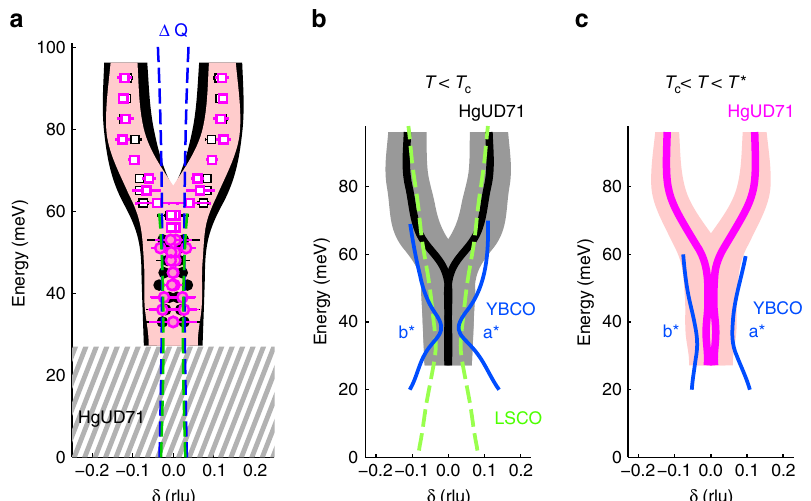
Figure 4 | Comparison of Y-shaped response of HgUD71 with magnetic excitation spectrum of YBCO and LSCO at similar doping levels. ( a ) Energy dependence of incommensurability d at 5K (black) and 85K (magenta), with d assumed to be non-zero at all energies. We arrive at an upper bound of d B 0.03 r.l.u., which corresponds to the half-width at half-maximum of the instrumental Q resolution (FWHM resolution for E i ¼ 70 and 130meV indicated by the green and blue dotted lines, respectively). Shaded black and red regions represent the measured FWHM (2 k ) at 5 and 85K, respectively. Hatched grey area indicates the gap in the excitation spectrum. ( b ) Comparison of the dispersion of HgUD71 with YBCO6.6 (ref. 7,8) and LSCO ( p ¼ x ¼ 0.085) (ref. 3) deep in the SC state. ( c ) Comparison of the dispersion of HgUD71 with YBCO6.6 above T c ( T ¼ 85 and 70K, respectively) 7 . The response of orthorhombic YBCO6.6 (blue lines) is anisotropic, and therefore d along both a* (right) and b* (left) is shown. As in a , the shaded regions in b , c indicate the momentum widths (FWHM) of the response of